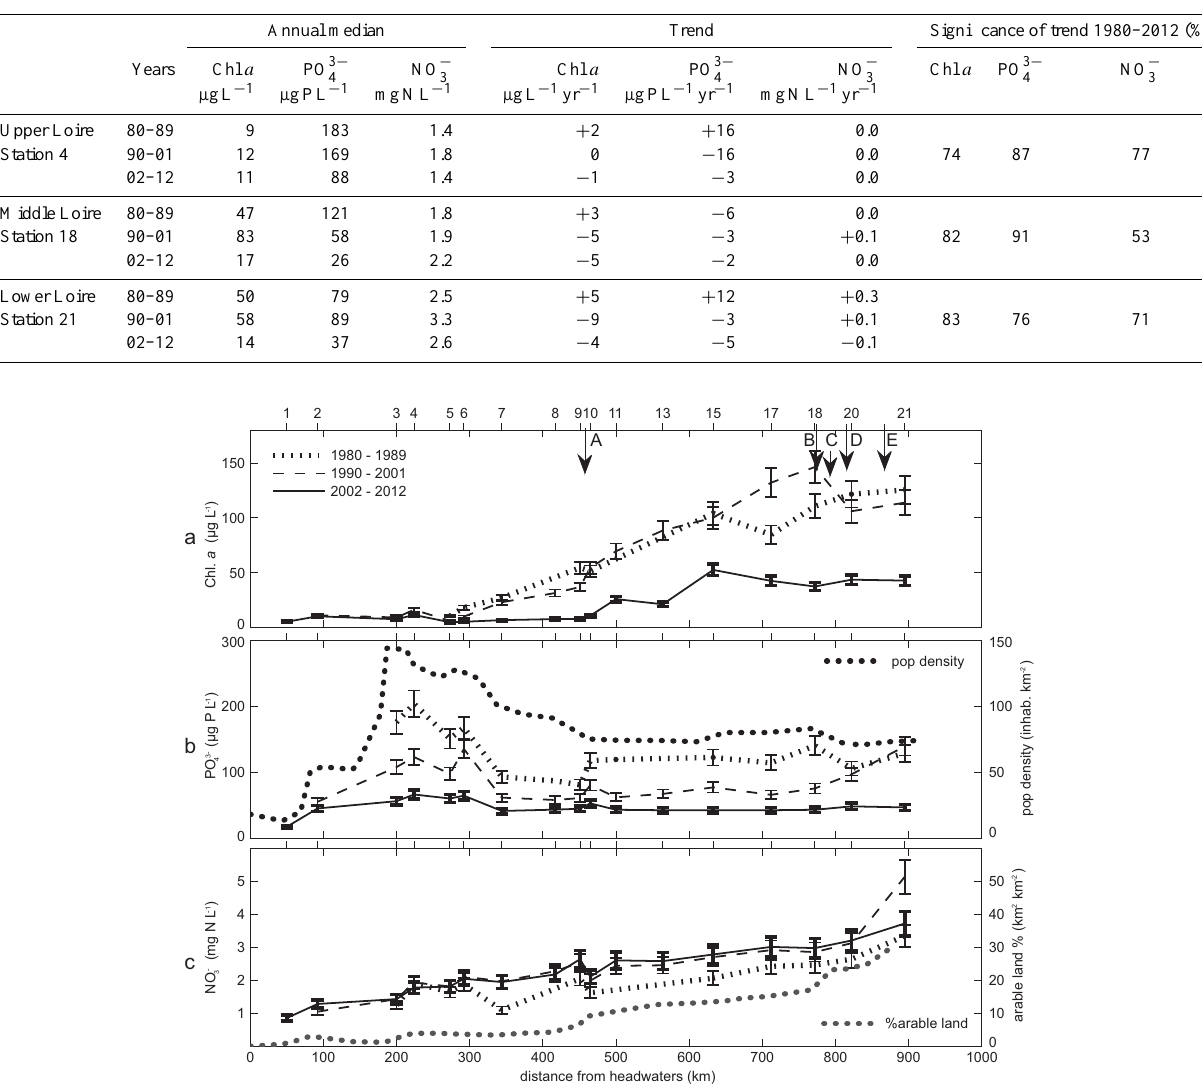
Figure 2. Longitudinal profiles of summer median Chl a (a) , winter median PO 3 − to percent arable land (2006) and population density (2008) tested as eutrophication control variables. Uncertainty bars are due to sampling frequency. Arrows and capital letters (A to E) represent confluences with major tributaries (Fig.